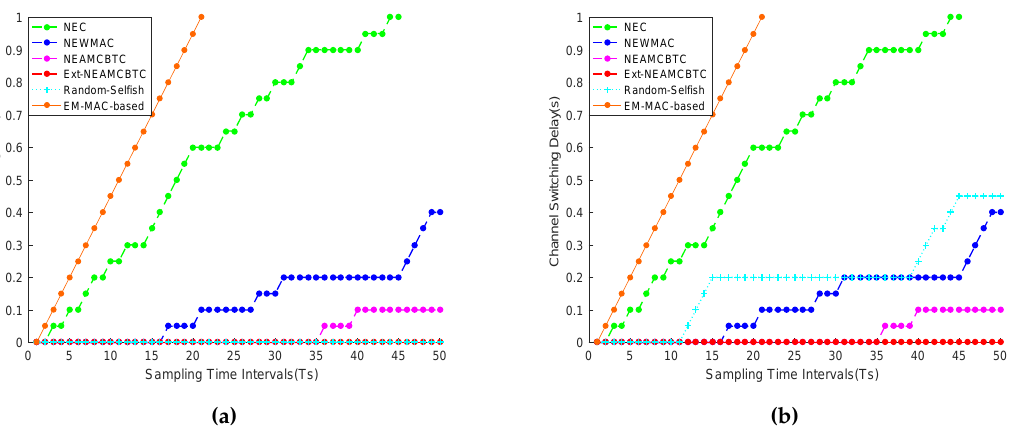
Figure 10. Channel switching delay overhead. ( a ) Case I: the channel switching delay measurement of discussed algorithms where Ext-NEAMCBTC and random selfish (in the above scenario) are behaving the best owing to no switching delay overhead, whereas the EM-MAC-based approach behaves the worst due to frequent channel hopping; ( b ) Case II: the channel switching delay measurement of discussed algorithms where Ext-NEAMCBTC behaves the best while random selfish (in the above scenario) behaves worse than NEWMAC technique. The varying behavior of random selfish approach is due to random channel